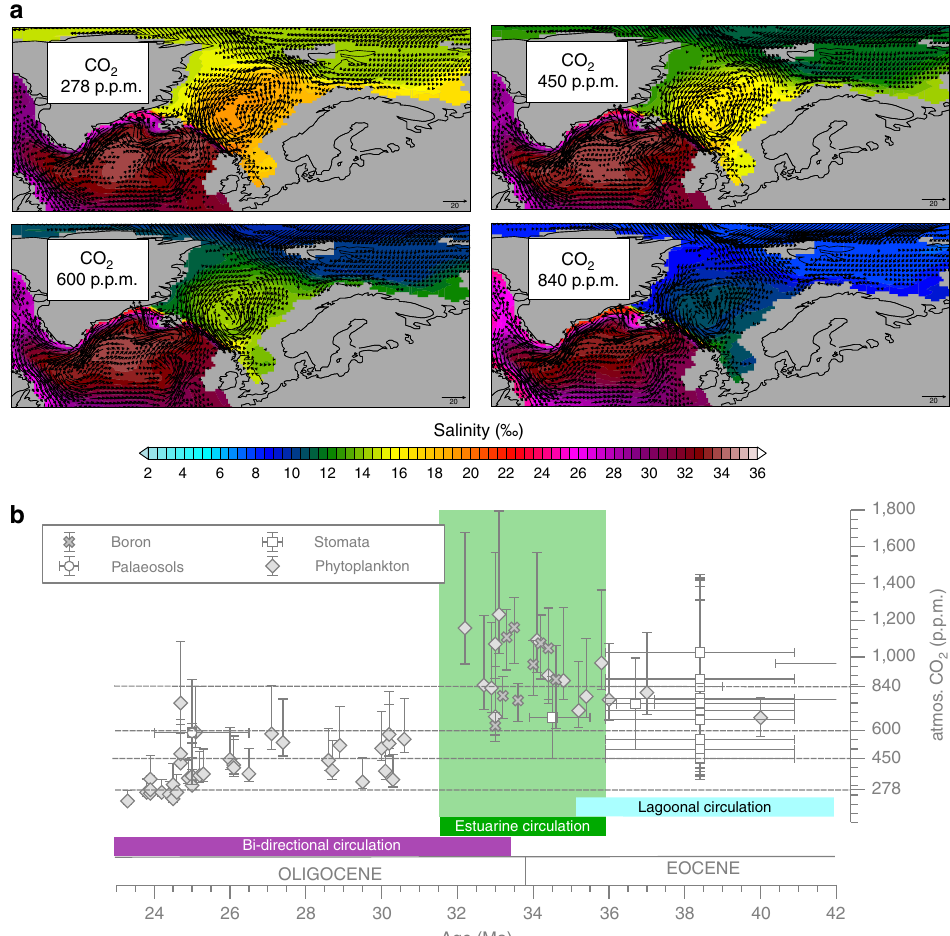
Figure 7 | North Atlantic-Arctic circulation regime modulated by atmospheric CO 2 levels at sensible Greenland-Scotland Ridge sill depths for circa 36 to 31.5Ma. ( a ) Salinity ( % ) and ocean velocity (cms (cid:2) 1 ; velocities o 0.5cms (cid:2) 1 are not shown) maps at water depths of 50metres below sea-level (mbsl) for model scenarios (sill depth at B 50mbsl) at 278, 450, 600, 840p.p.m. CO 2 in the atmosphere, respectively. ( b ) Evolution of Greenland-Scotland Ridge gateway circulation and different atmospheric CO 2 levels set into context of reconstructed CO 2 proxy history (error bars show documented uncertainties) 25,26